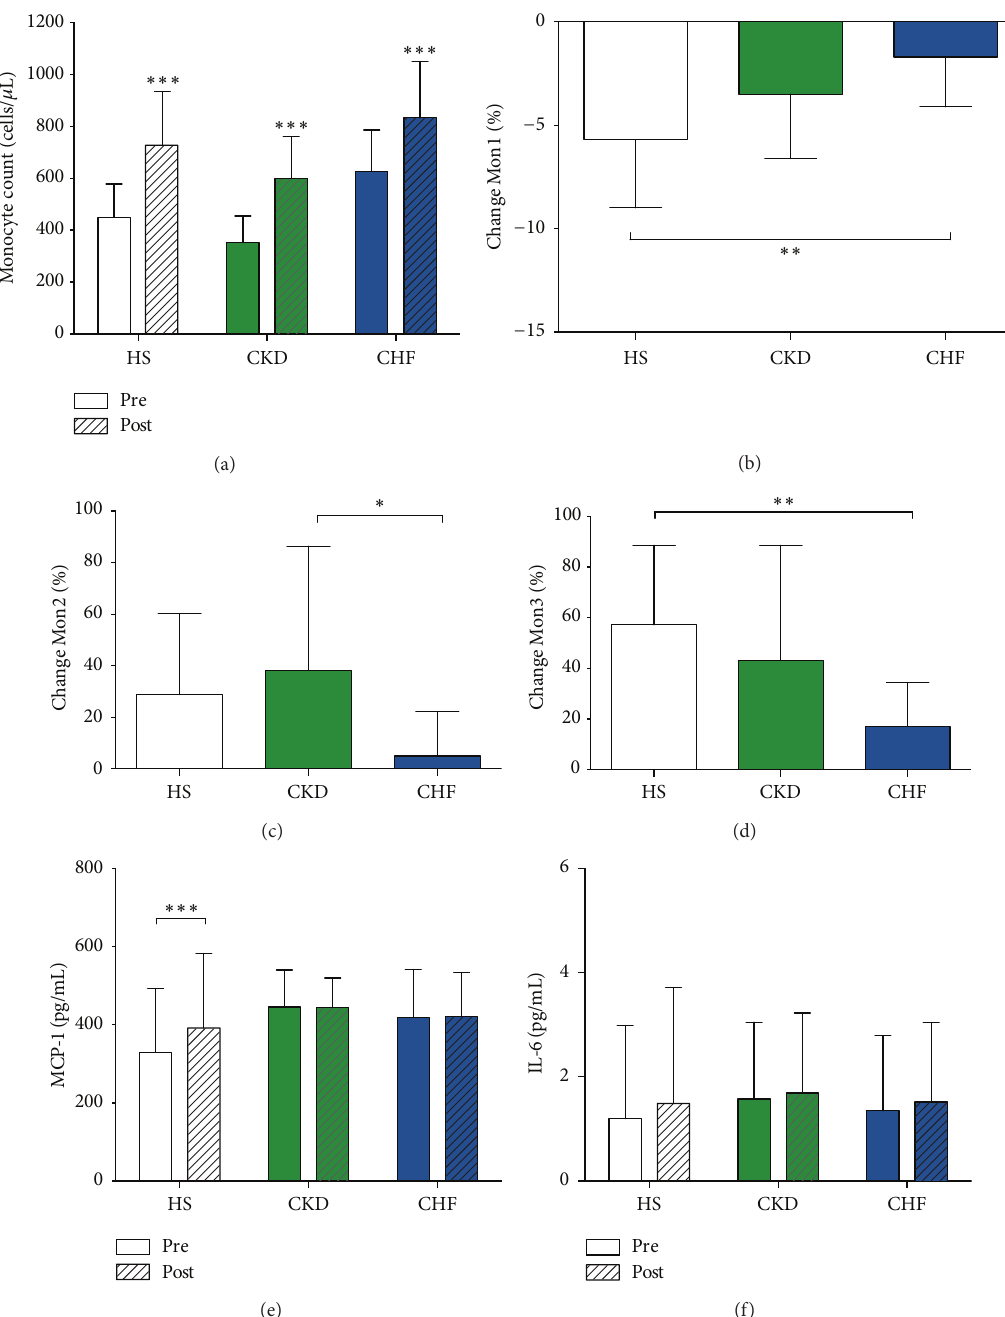
Figure 2: Magnitude of the exercise-induced effect on monocyte count, monocyte subsets, and serum MCP-1 and IL-6 levels. (a) Following peak exercise, absolute monocyte count increased significantly in all groups. (b–d) Within the total monocyte count, the percentage of Mon1 decreased in all three groups with a parallel increase in Mon2 and Mon3 (with exception of Mon2 in CHF). Between-group analysis revealed that the overall response of the monocyte subsets was comparable between HS and CKD but was significantly blunted for patients with CHF ( 𝑃 for interaction < 0.05 for all subsets). (e) Following peak exercise, MCP-1 levels increased significantly in HS but remained unchanged in patients with CKD and CHF ( 𝑃 = 0.004 for interaction). (f) Increase in IL-6 levels were observed in all groups but failed to reach the level of significance (HS 𝑃 = 0.08 ; CKD 𝑃 = 0.644 ; CHF 𝑃 = 0.063 ). Changes in monocyte subset are expressed as % change from baseline. ∗∗∗ 𝑃 < 0.001 , ∗∗ 𝑃 < 0.01 , and ∗ 𝑃 < 0.05